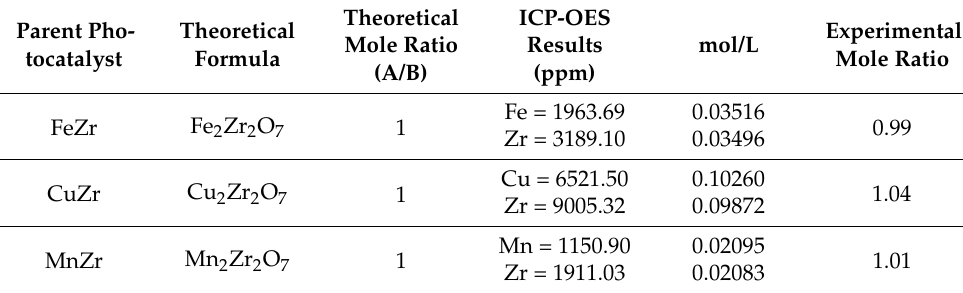
Table 3. ICP-OES analysis for the M 2 Zr 2 O 7 .